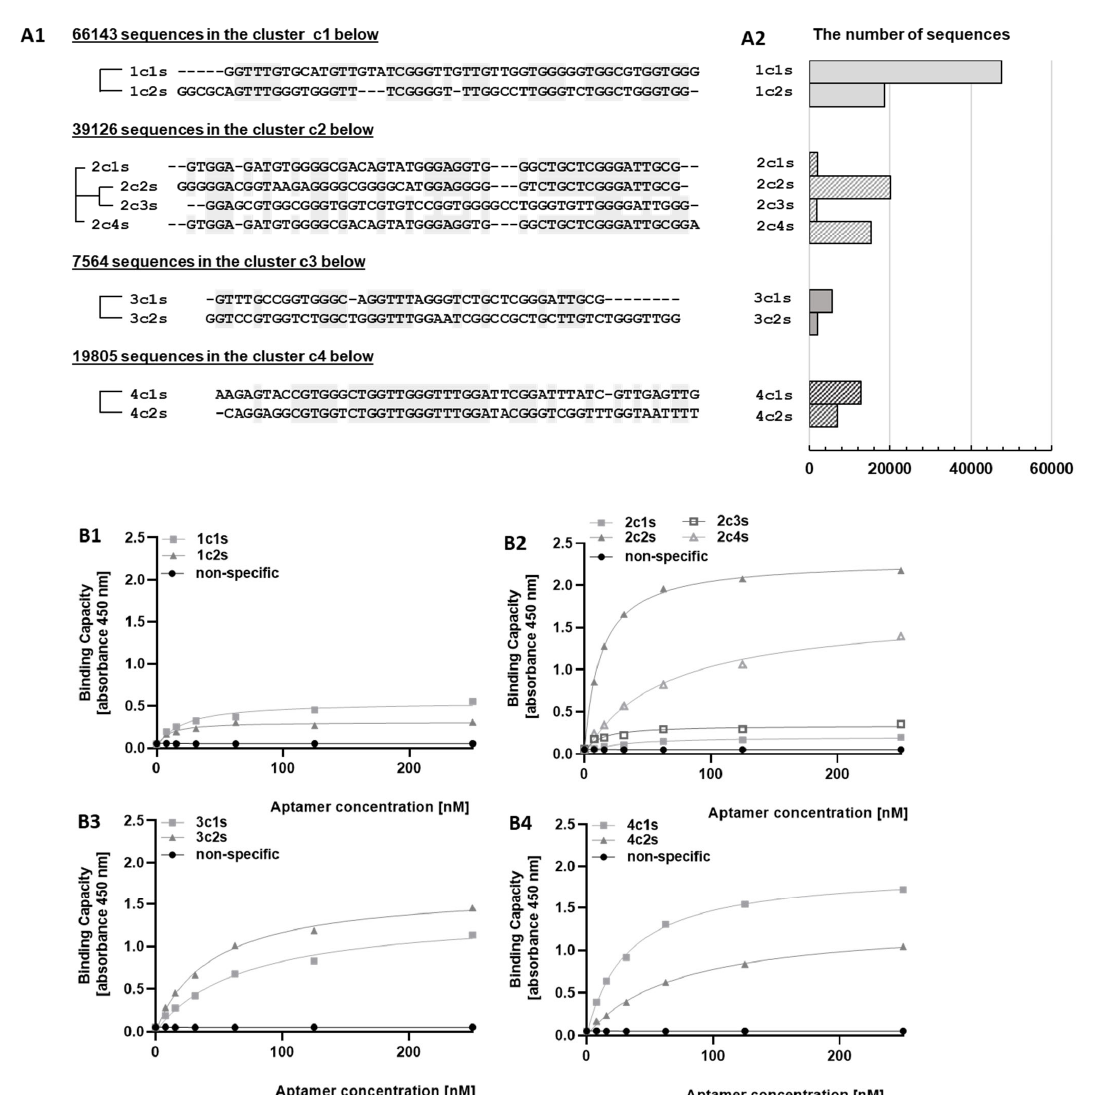
Figure 2. Aptamer analysis after the last (7th) selection cycle. ( A1 ) (pseudo ‐ ) phylogenetic trees gen ‐ erated based on the multiple sequence alignment (MSA) of sequences belonging to indicated clus ‐ ters. Trees were created for clusters of >2 sequences. ( A2 ) number of sequences in groups shown in A1 ( B1 – B4 ) ELISA was used to determine the binding capacity of representative aptamers